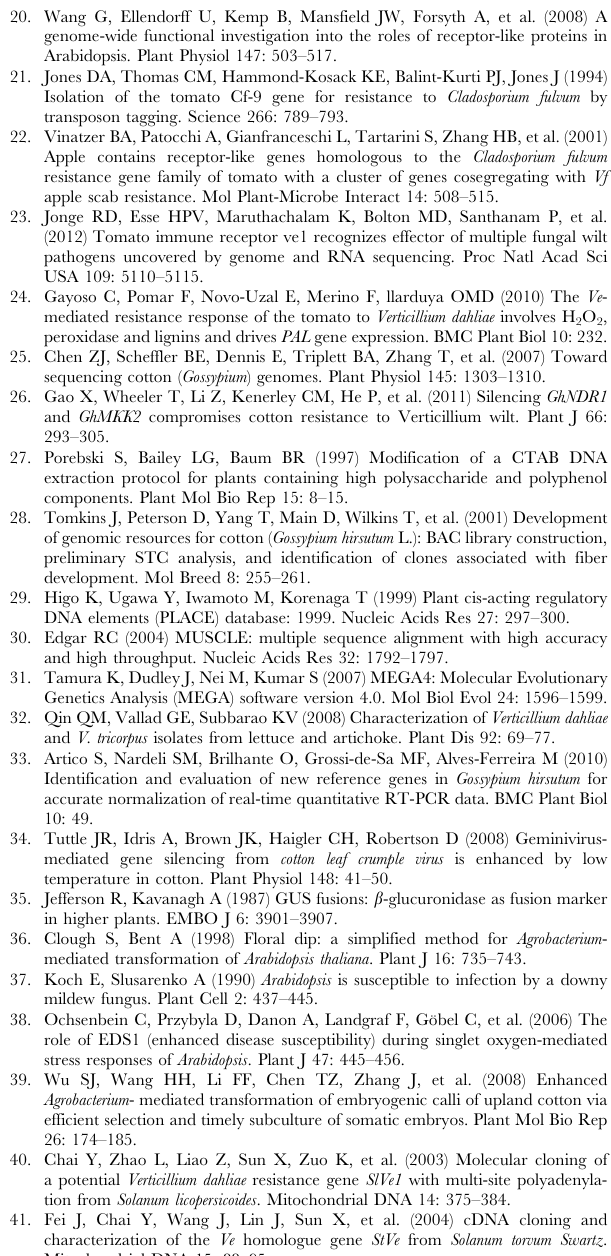
Table S2 The used primers in this